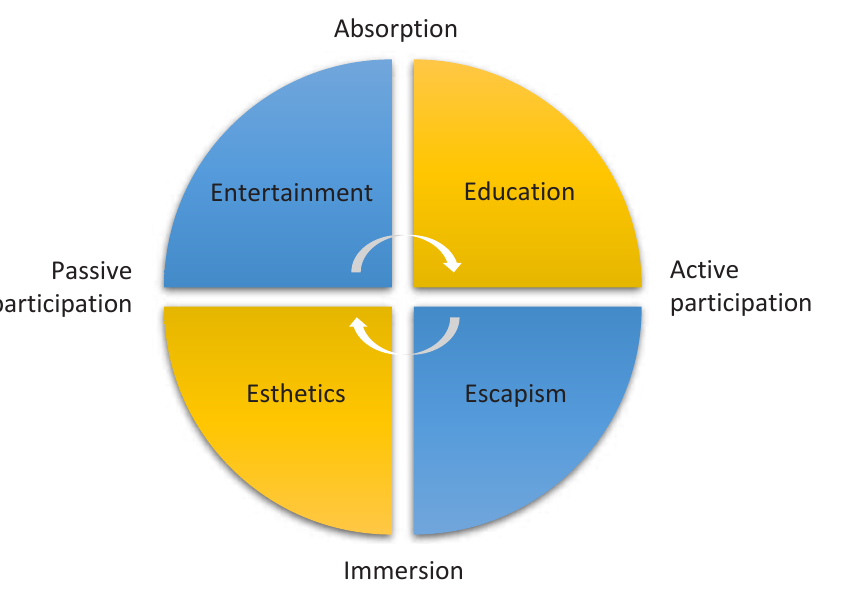
Source: Pine and Gilmore